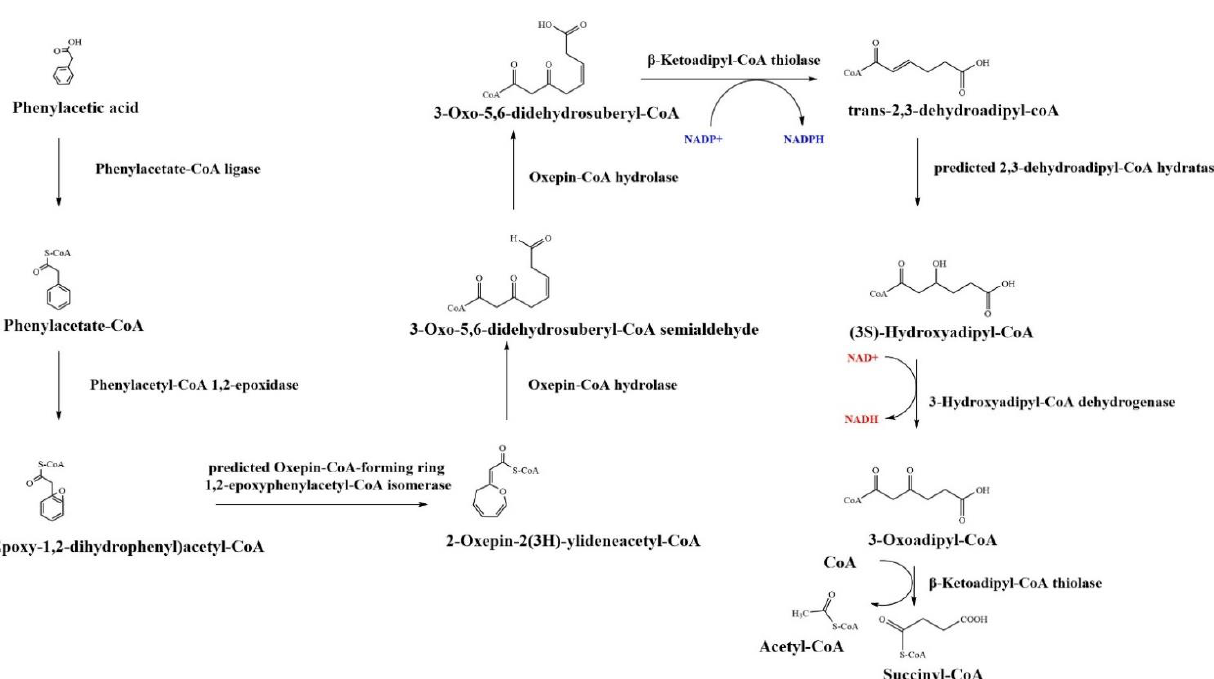
Figure 6. The degradative pathways of phenylacetic acid. Phenylacetate is degraded into tricarboxylic acid (TCA) cycle intermediates through the central metabolic pathway [84,85].